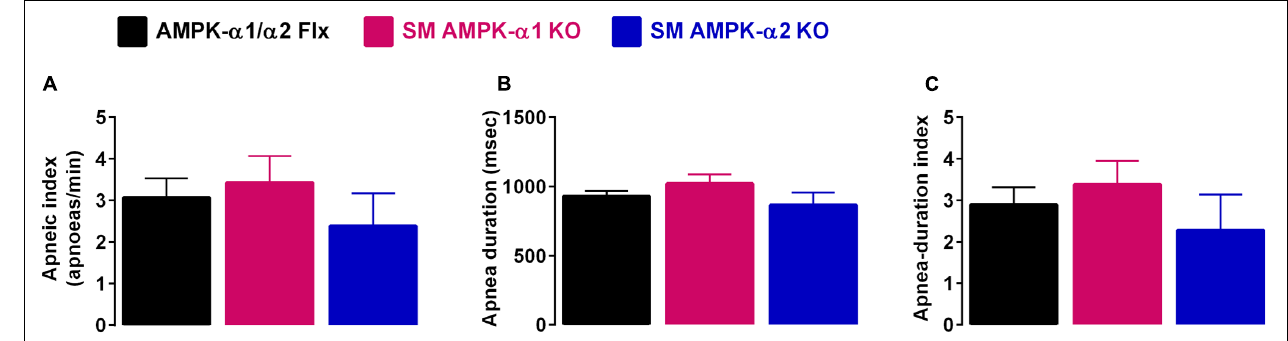
FIGURE 2 | Deletion of AMPK- α 1 and AMPK- α 2 subunits in smooth muscles does not affect apnea frequency or duration during hypoxia. Bar charts show mean ± SEM for the (A) apneic index (per minute), (B) apnea duration, and (C) apnea duration index (frequency × duration) of AMPK- α 1/ α 2 floxed mice (Flx; black, n = 12), and for mice with AMPK- α 1 ( n = 4; magenta) and AMPK- α 2 ( n = 4; blue) deletion in smooth muscles (transgelin expressing cells).